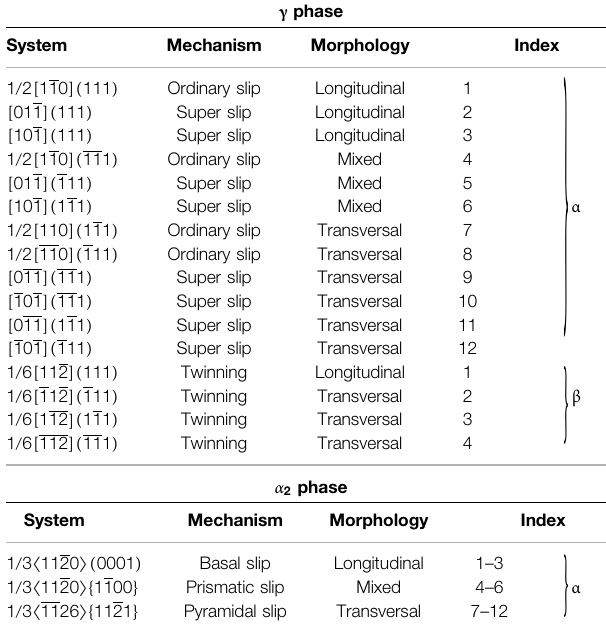
FIGURE 1 | Left: Schematic depiction of the coextisting microstructural interfaces in fully lamellar TiAl. λ L : lamella thickness; λ D : domain size; λ C : colony size; λ α distancebetween α 2 lamellae.Right:OrientationrelationbetweenthehexagonalD0 19 latticeofthe α 2 phaseandtheface-centeredtetragonalL 10 latticeofthe γ phasein lamellar colonies. c I − III M : matrix orientations; c I − III T : twin orientations. Figure taken from Schnabel (2018).